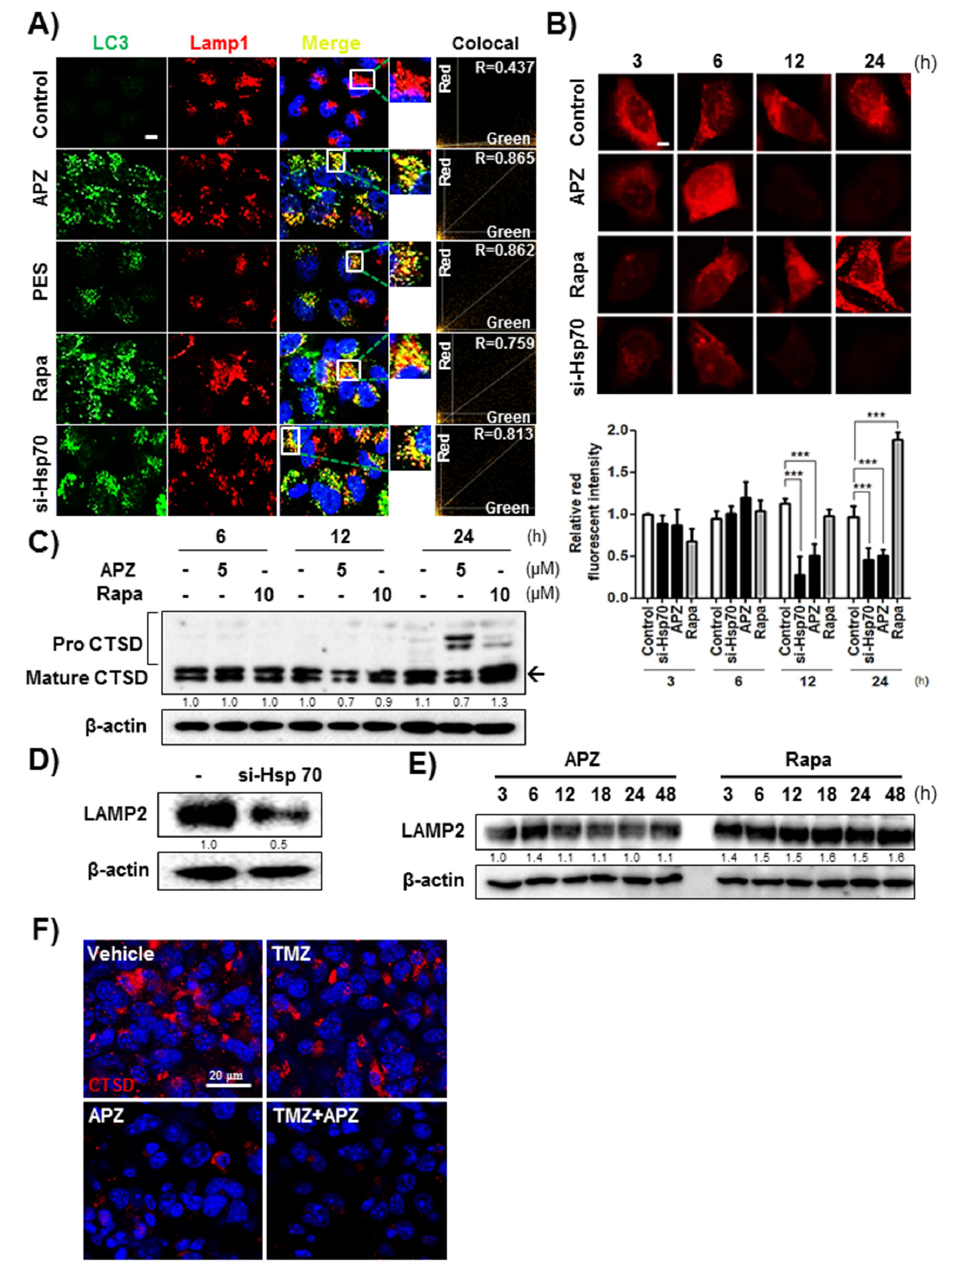
Figure 8. Hsp70 inhibition by APZ affects lysosomal integrity. ( A ) Immunocytochemistry staining with red fluorescent protein (RFP)-tagged LAMP1 and green fluorescent protein (GFP)-tagged LC3 with Hsp70 siRNA transfection or compounds in HeLa cells. The samples were treated with APZ (5 µ M), PES (5 µ M), rapamycin (10 µ M), and si-Hsp70 vector (10 nM) for 24 h. The colocalization of GFP-LC3 and RFP-LAMP1 was monitored by confocal microscopy. Scale bar, 20 µ m. ( B ) Acridine orange staining was used to visualize lysosomal integrity. The samples were treated with APZ (5 µ M), rapamycin (10 µ M), and si-Hsp70 vector (10 nM) for 24 h. Cells were treated with acridine orange (2 µ g / mL) for 20 min before fixation. After fixation, samples were examined by confocal microscopy. Scale bar, 10 µ m. Graph indicates fluorescence quantification. Values are means ± SEM; n > 30 cells. *** p < 0.001. ( C ) Immunoblot analysis indicating altered processing of cathepsin D from the prevalent premature form to the mature form after APZ treatment (5 µ M) for 24 h. ( D ) Immunoblot analysis upon si-Hsp70 transfection (10 nM) indicating decreased expression of LAMP2 in HeLa cells. ( E ) Expression of LAMP2 decreased alone upon treatment with APZ (5 µ M) for 48